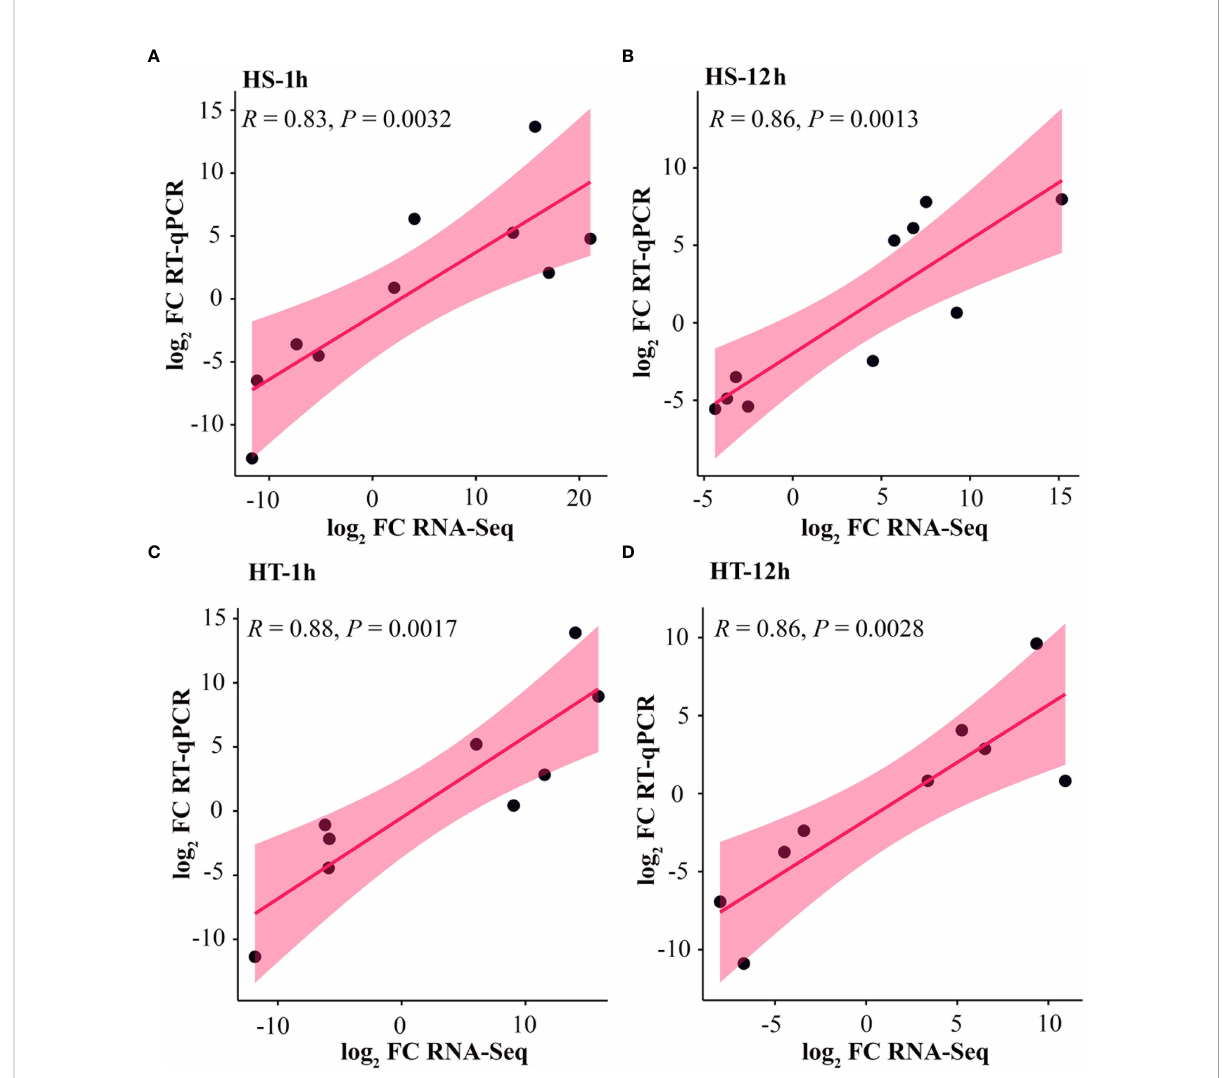
FIGURE 7 Validation of ten differentially expressed genes in heat-sensitive (3T-6) and heat-tolerant (Youlu-501) fl owering Chinese cabbage based on RT- qPCR. The RNA-seq and RT-qPCR values in the form of log 2 fold-change were plotted using linear regression analysis at (A) HS-1, (B) HS-12h, (C) HT-1h, and (D) HT-12h. R and P indicate the correlation coef fi cient and corresponding P